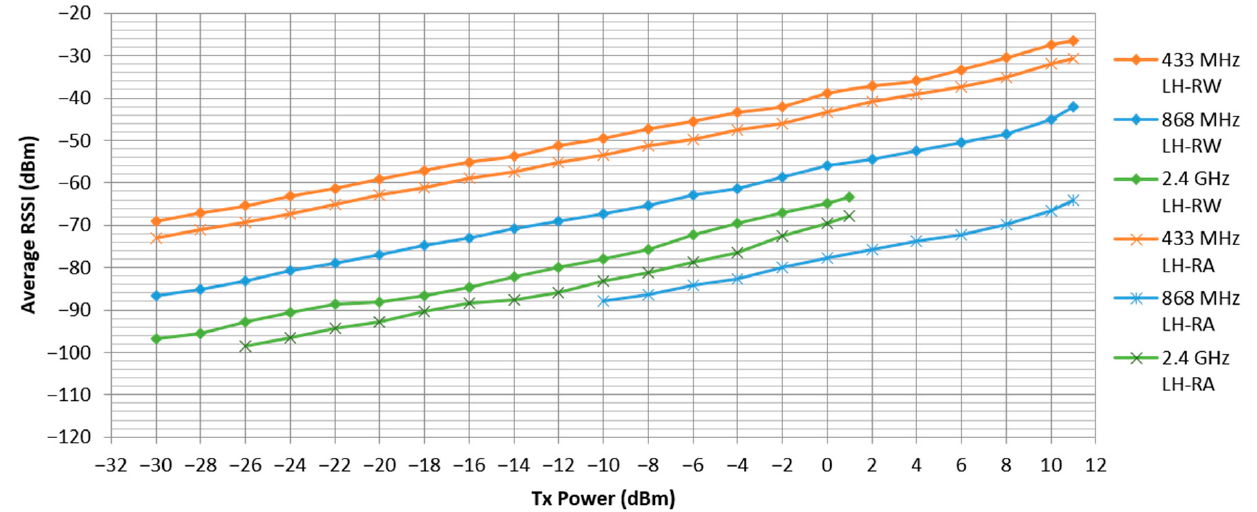
Figure 7. Average RSSI in the sitting scenario.